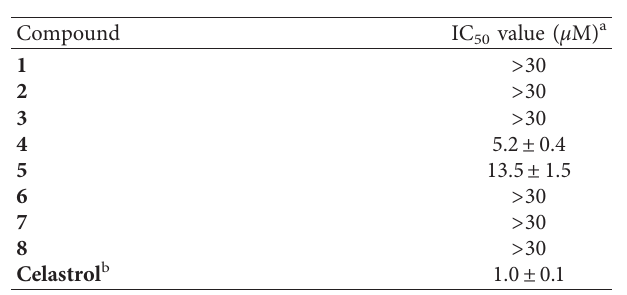
Figure 2: Effect on cell viability by LPS stimulation in the presence of compounds 1 – 8 . Cell viability was determined by the MTS assay and expressed as a percentage of the control without the addition of indicated compounds 1 – 8 . Table 1: NO production inhibitory activity of isolated compounds 1 – 8 .